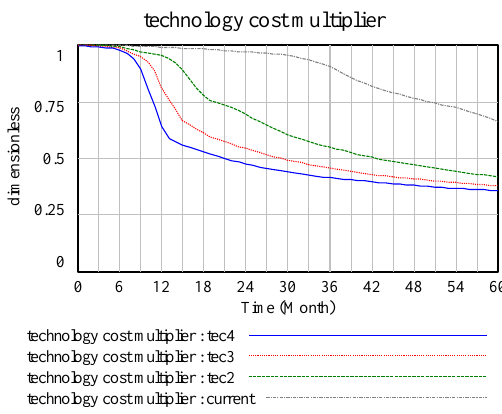
Figure 7. Technology and technology change rate.